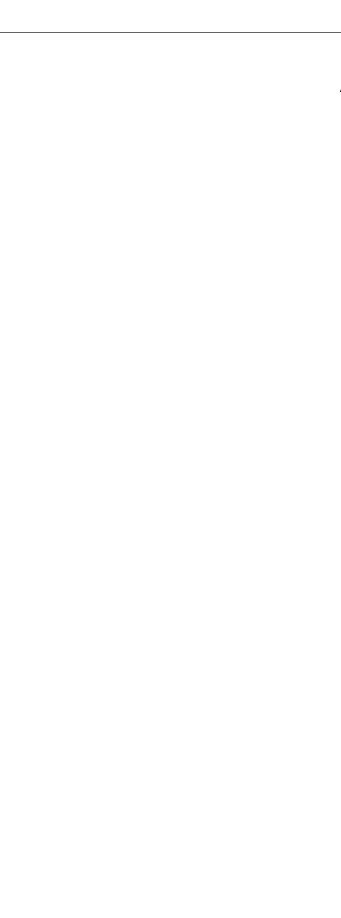
FIGURE 6 | Abrogation of G2/M cell cycle checkpoint in miR-506-3p reconstituted cells. Western blot analysis on total cell lysates from SKOV3 cells transfected with miR-506-3p or scrambled (scr) miRs and following treatment with 1 or 3µM Pt. Immunoblottings were performed with antibodies against the proteins indicated. Vinculin was used as loading control. Representative western blot images (A) and quanti fi cation (B) of relative phosphorylation levels calculated as the ratio between phosphorylated and total protein normalized on loading control. Bars in the graph represent the phosphorylation ratio between Pt-treated and untreated cells. Only signi fi cant comparison assessed by Student ’ s t test are reported (* p<0.05; ***